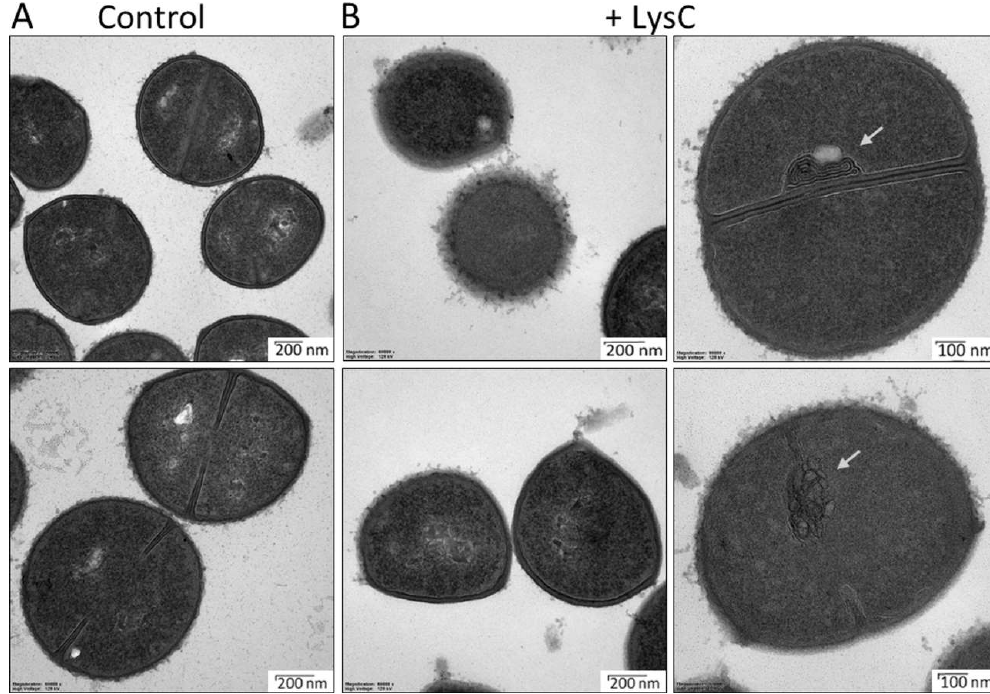
Figure 4. Transmission electron microscopy of Staphylococcus aureus ATCC 25923 cells treated with LysC enzyme. ( A ) Untreated cells of S. aureus ATCC 25923; ( B ) S. aureus ATCC 25923 treated with LysC (500 μg/mL) for 1.5 h at 37 °C. The dark and light areas correspond to high and low electron densities of the samples, respectively. Grey arrows show abnormal membranes accumulation, which was characteristic for many cells after incubation with LysC.